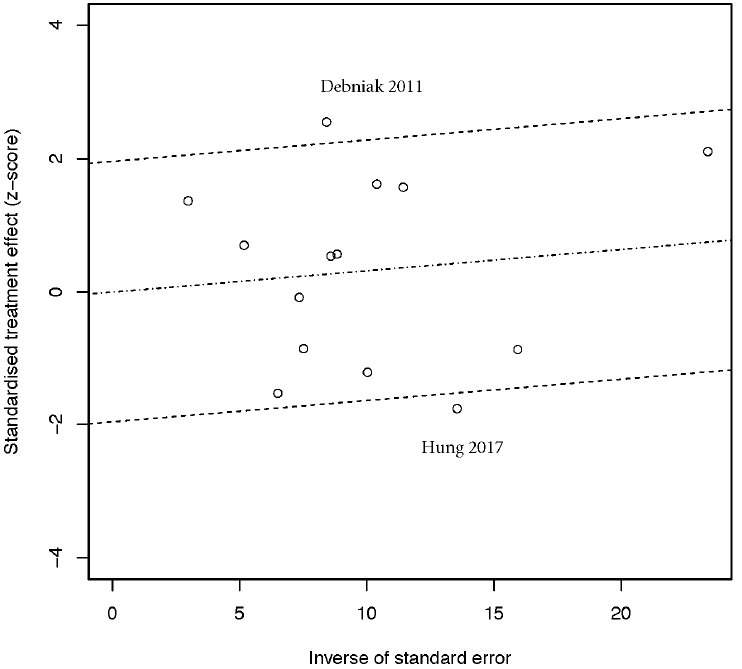
Figure 6. Galbraith plot for the source of between-study heterogeneity under the allele model. Each point represents one single study involved in this meta-analysis. The source of heterogeneity was marked by the author’s name and publication year.